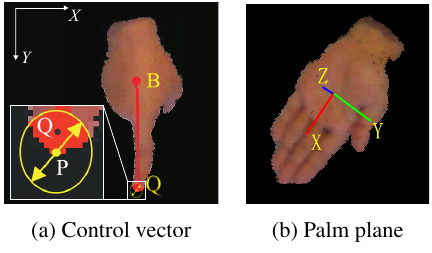
Figure 4: Control data